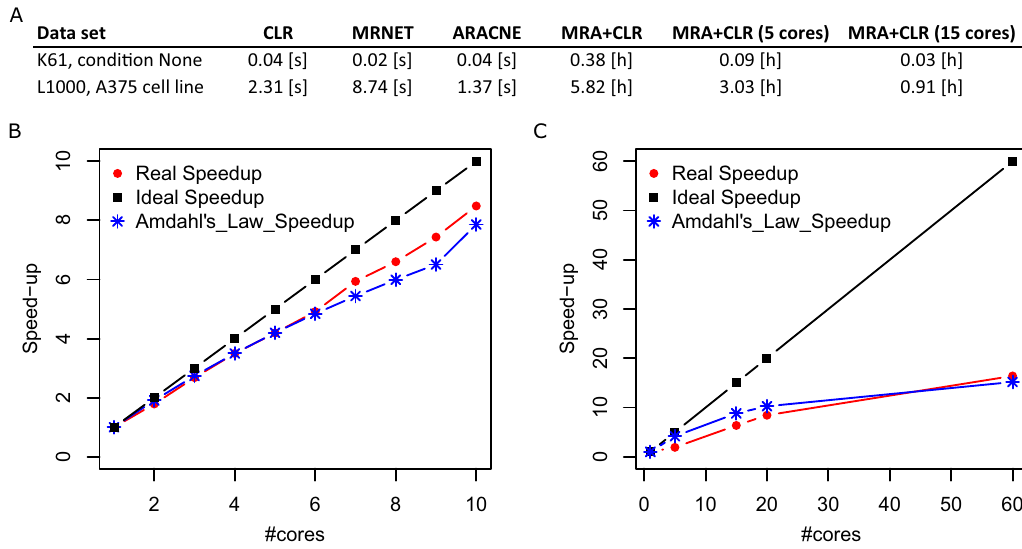
Fig 7. Execution times. (A) Execution times on two representative experimental networks. Note that MRA+CLR times are in hours instead of seconds. MRA times are identical to MRA+CLR times. (B) K61 data (None condition, 61 × 61 matrix) speedup curve. Amdahl’s Law is a commonly used model for the best achievable speedup. (C) L1000 shRNA data (A375 cells, 938 × 938 matrix).